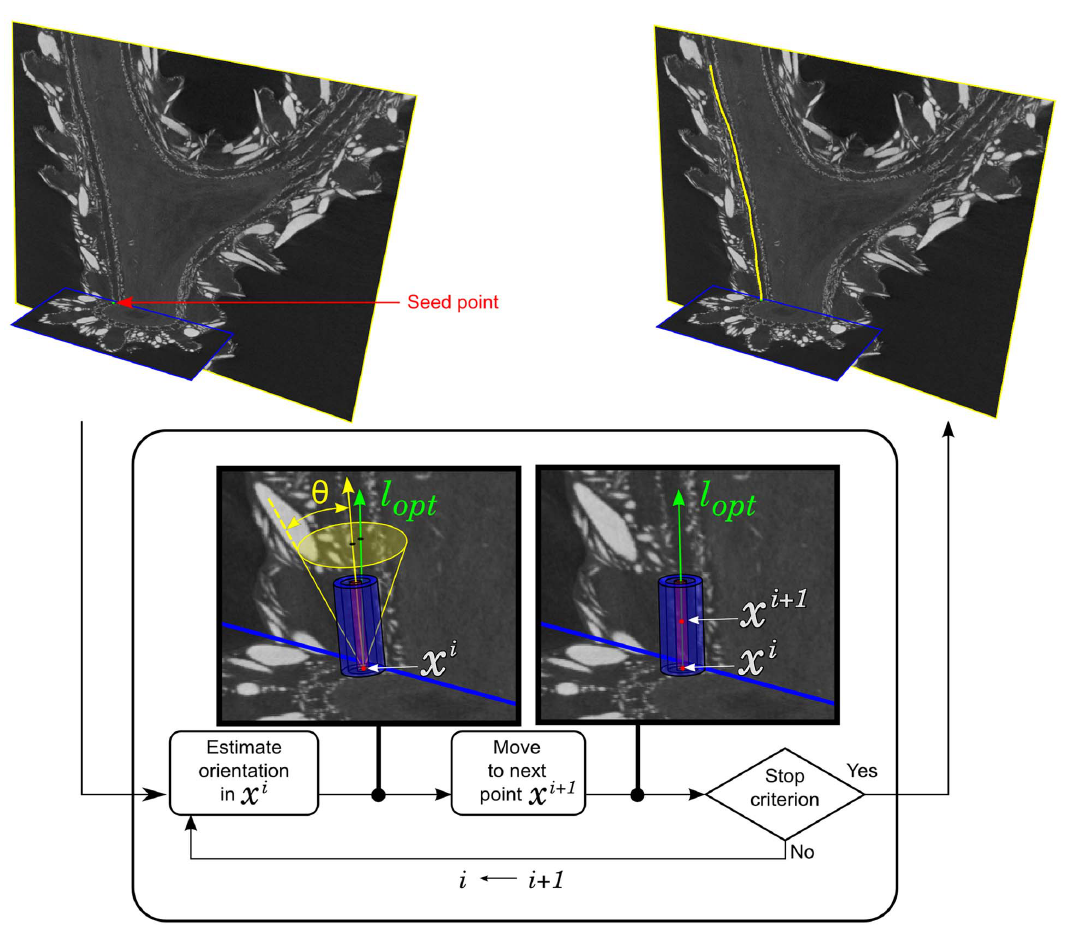
Figure 7. Flowchart of the pathway extraction algorithm. The yellow arrow indicates the previous orientation, while the green one represents the currently found optimal